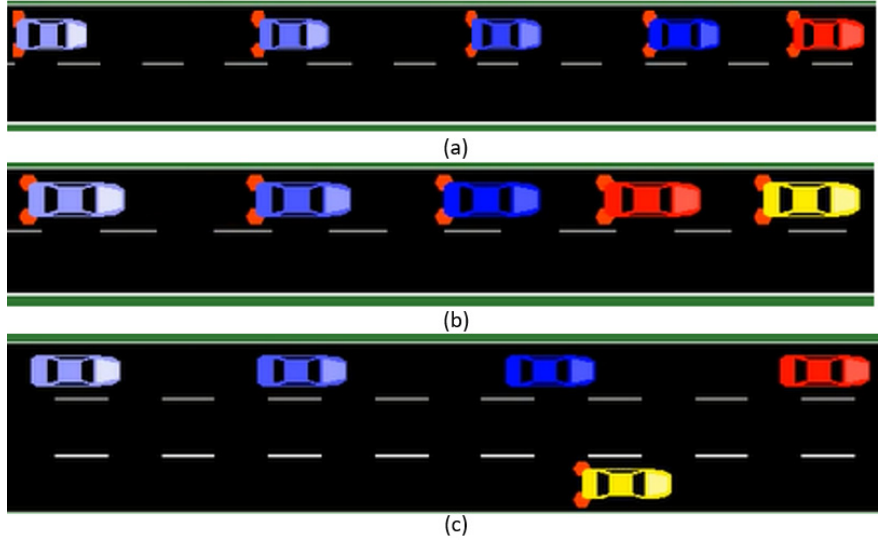
Figure 15. Resilient scenario simulation in VENTOS.